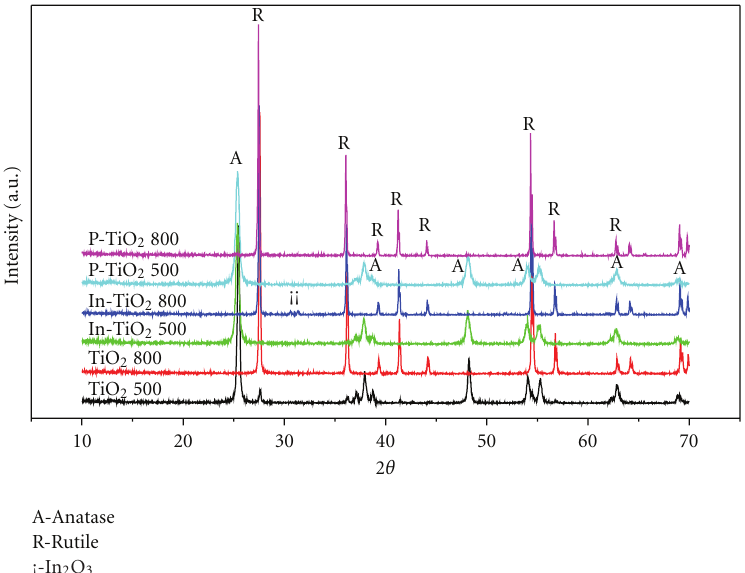
Figure 2: XRD patterns of 1.0 mol% P, In-TiO 2 , and TiO 2 photocatalysts treated at 500 ◦ C (anatase phase) and 800 ◦ C (rutile phase).